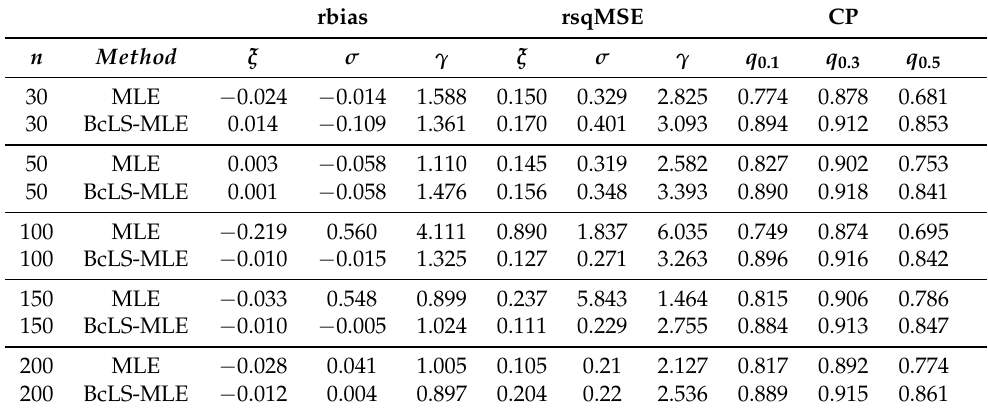
Table 6. The rbias and rsqMSEs of the BcLS-MLE and MLE, and the CP of S ( y 0 | Θ ) for LPN ( Θ ) with